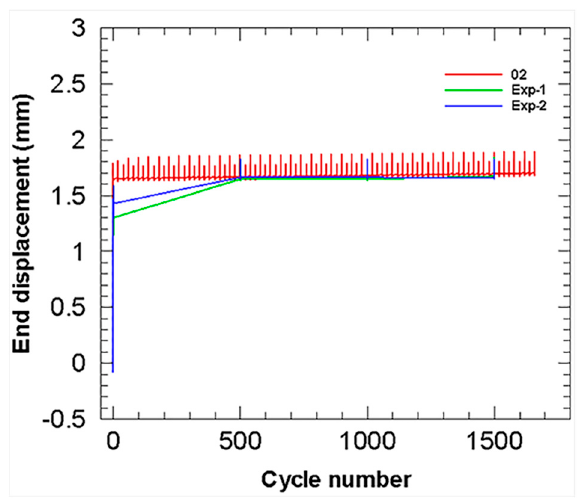
Figure 8. End displacement of the CG specimen associated with No. 2 random field. Metals 2018 , 8 , x FOR PEER REVIEW